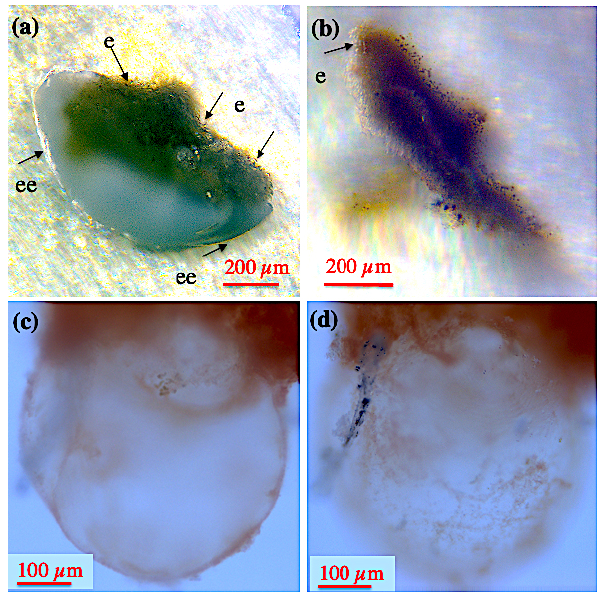
Figure 2. Shell envelope II. (a) Shell envelope apparent on the umbilical side of an adult C. lobatulus specimen, whereas an al- gae half cyst was formed over a period of 6 weeks over the spiral side. (b) The half cyst 1–2d after it has been abandoned (cyst was shed during the weekend). (c–d) Abandoned shell envelope of a C. pachyderma specimen retrieved after the termination of the Cibi- cidoides pachyderma experiment. Panels (c) and (d) show the same cyst but different focussing. “ee” denotes ectoplasmic envelope; “e” denotes remains of